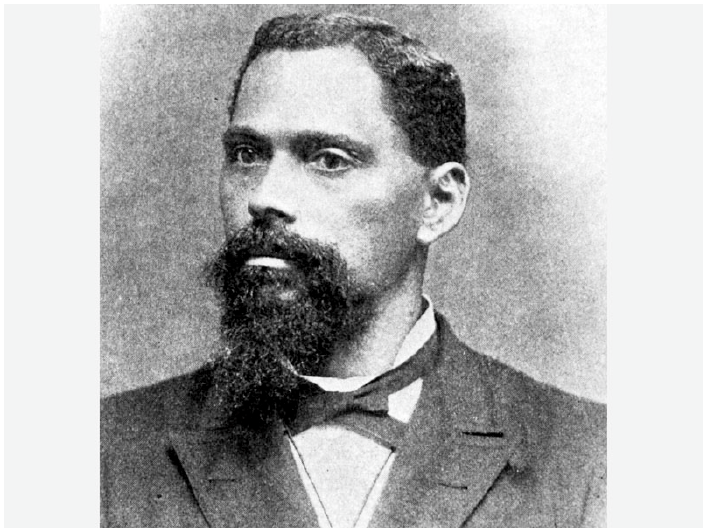
Figure 10. Bishop Lucious Henry Holsey. Public Domain.